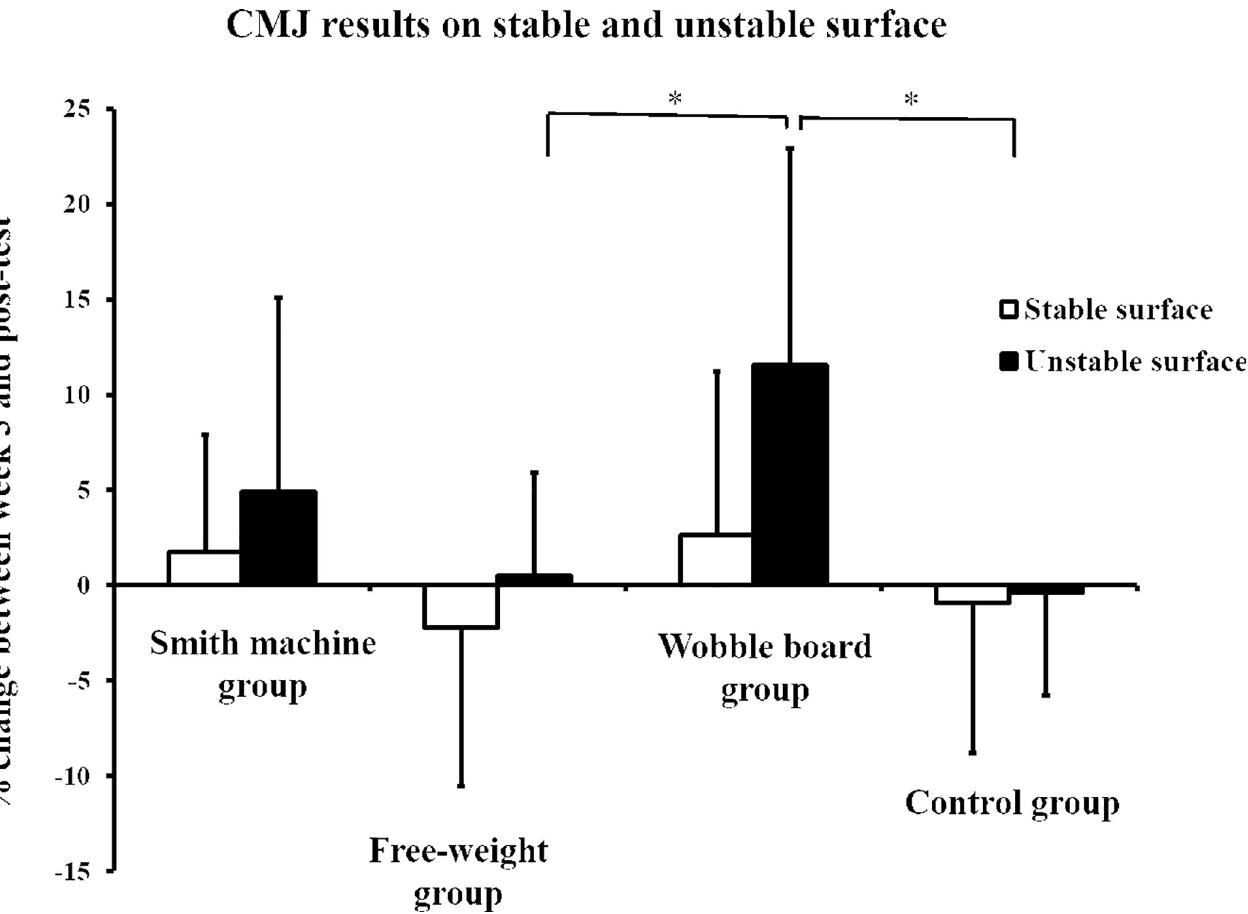
Fig 4. Improvement in CMJ on stable and unstable